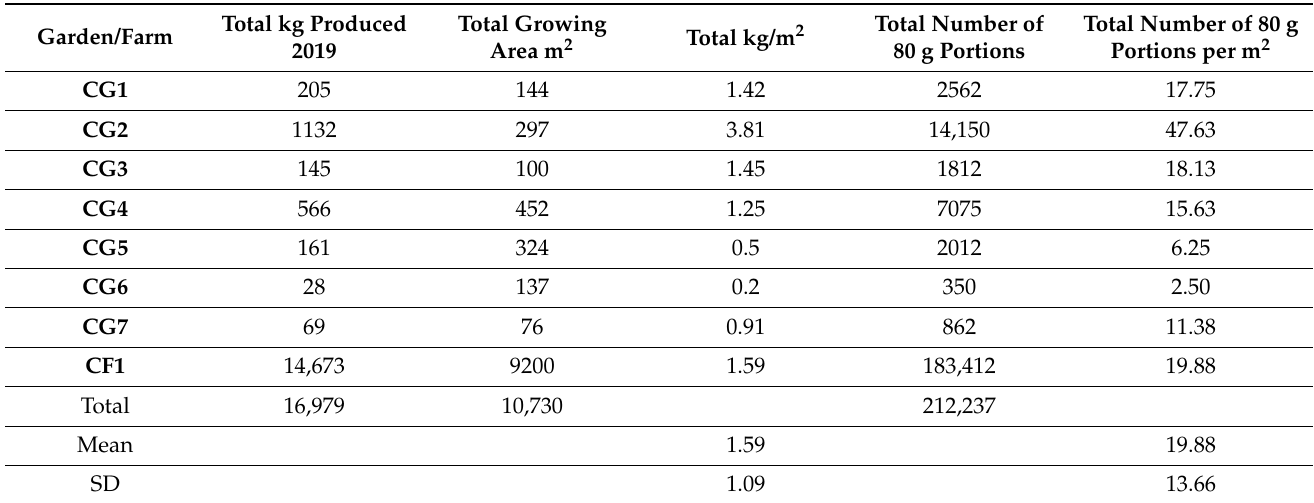
Table 3. Total number of portions produced per garden in